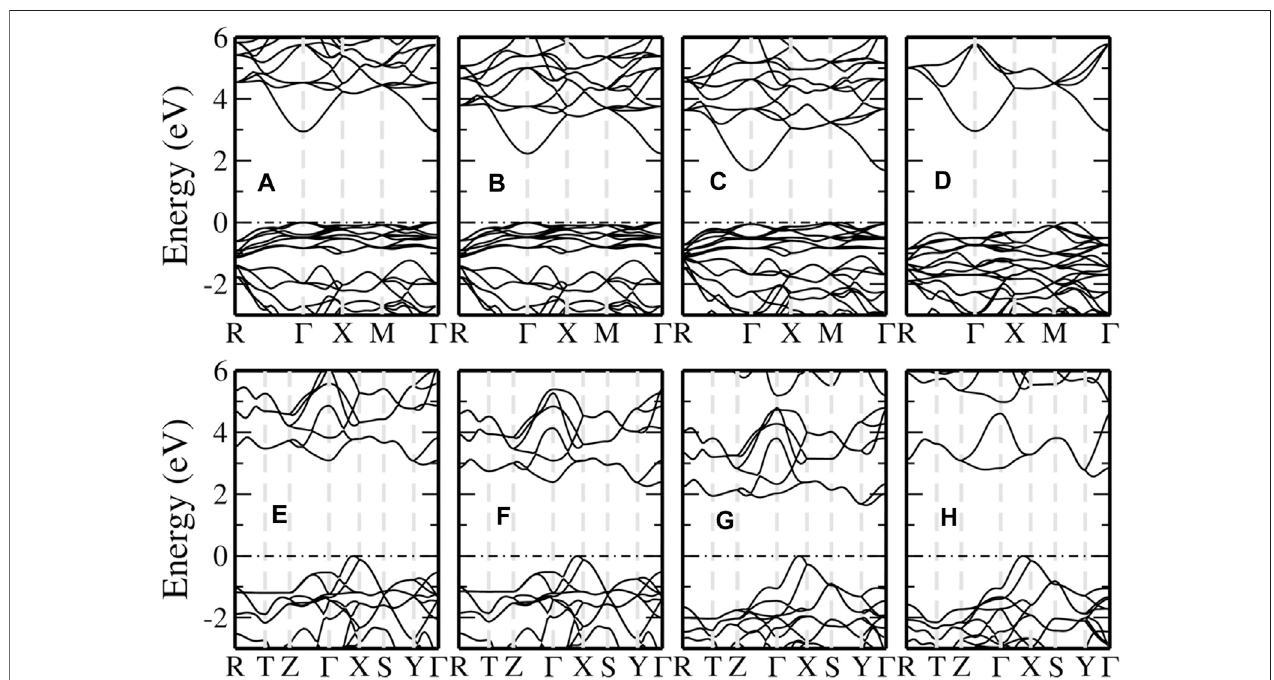
FIGURE 6 | Band structures of pyrite (upper panel) and marcasite (lower panel) FeS 2 computed from different hybrid functional methods. From left to right, the methodsusedarePBE0 (A,E) ,HSE06 (B,F) ,SX-PBE (C,G) andDSH (D,H) ,respectively.Thevalencebandmaximumisalignedastheenergyzeroandindicatedbythe black dash-dotted line.